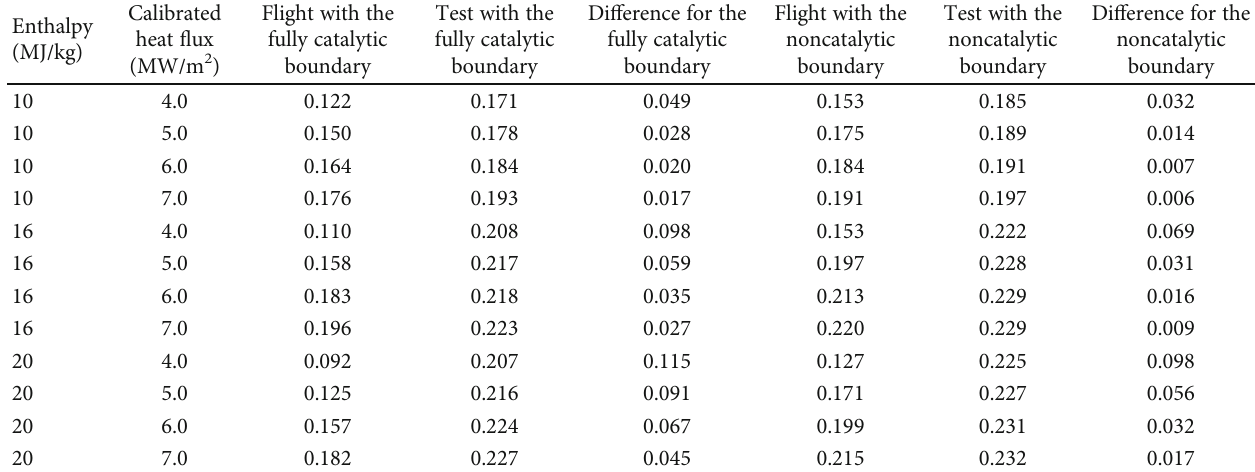
Table 3: The peak mass fraction of the oxygen atom after the shock wave.